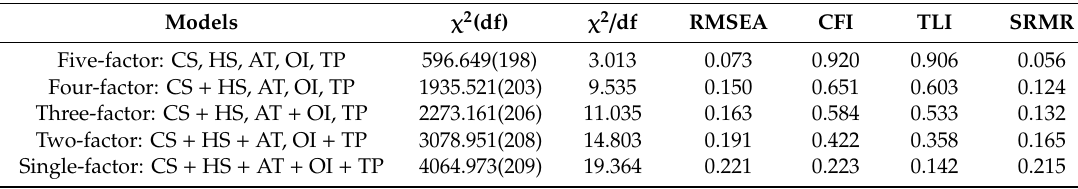
Table 1. Results of the confirmatory factor